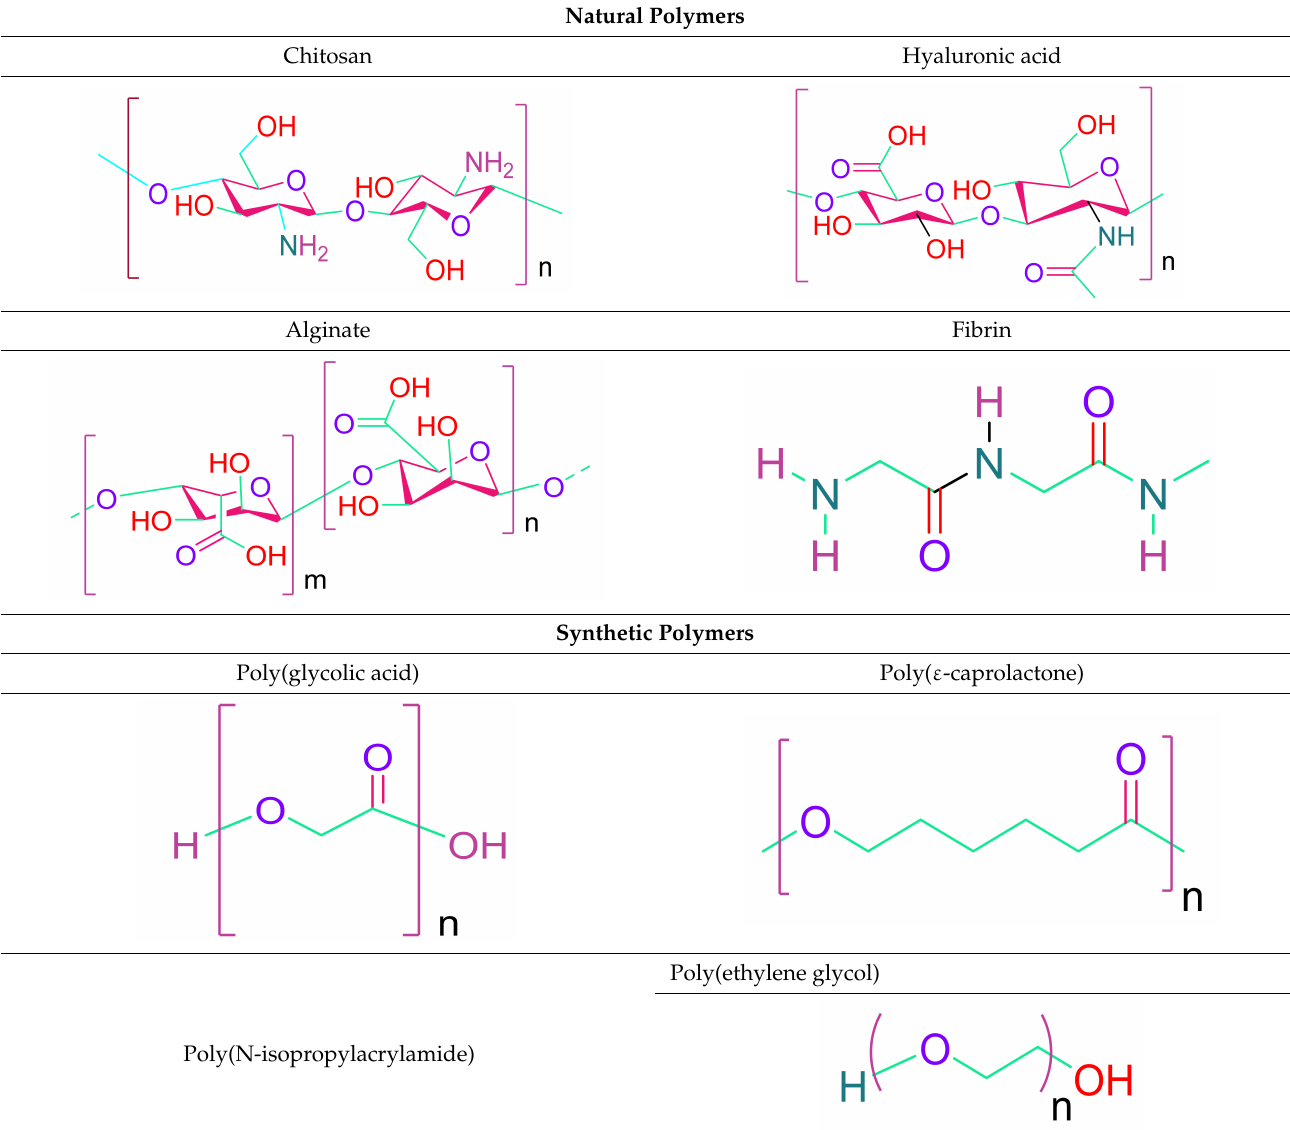
Table 2. Types of natural and synthetic polymers used during cardiac tissue